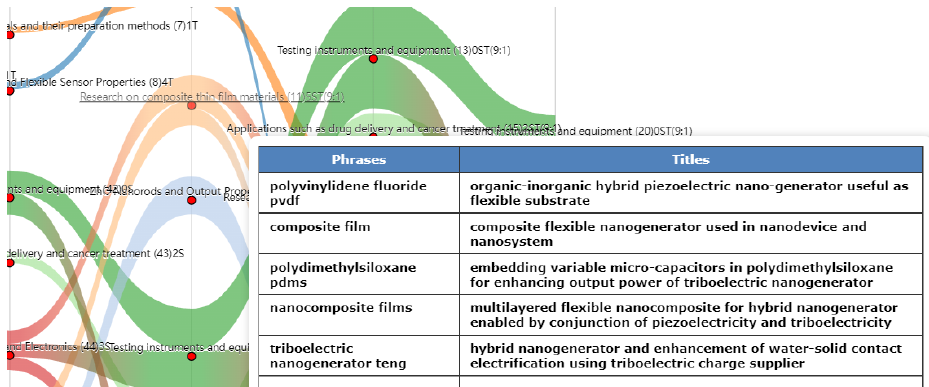
Figure 3. Information presentation of fusion themes.